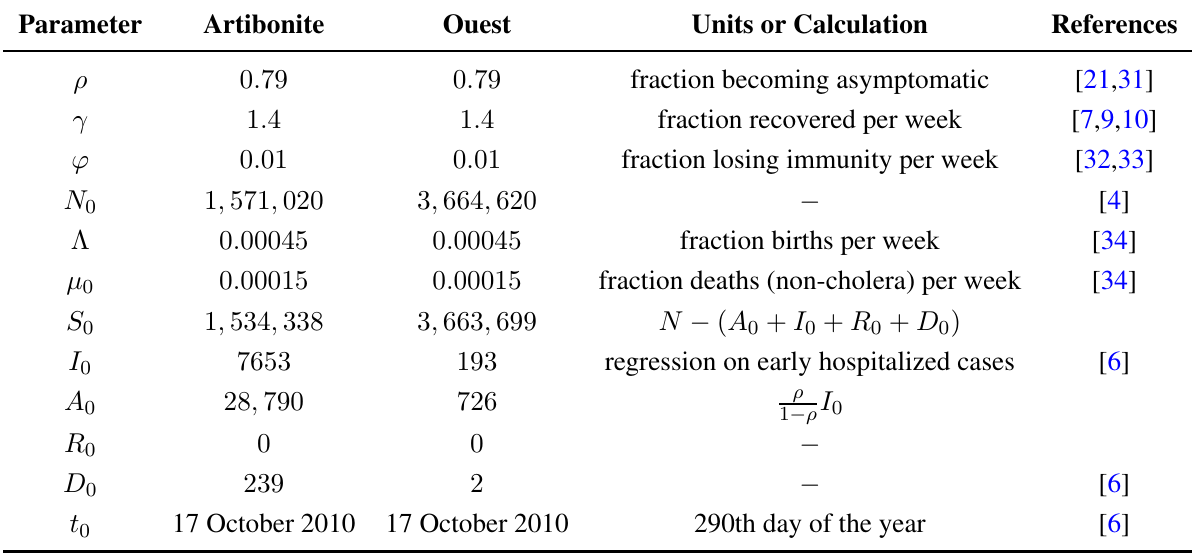
Table 1. Parameter values obtained from the literature, simple calculation or by definition (sources are in the last column).